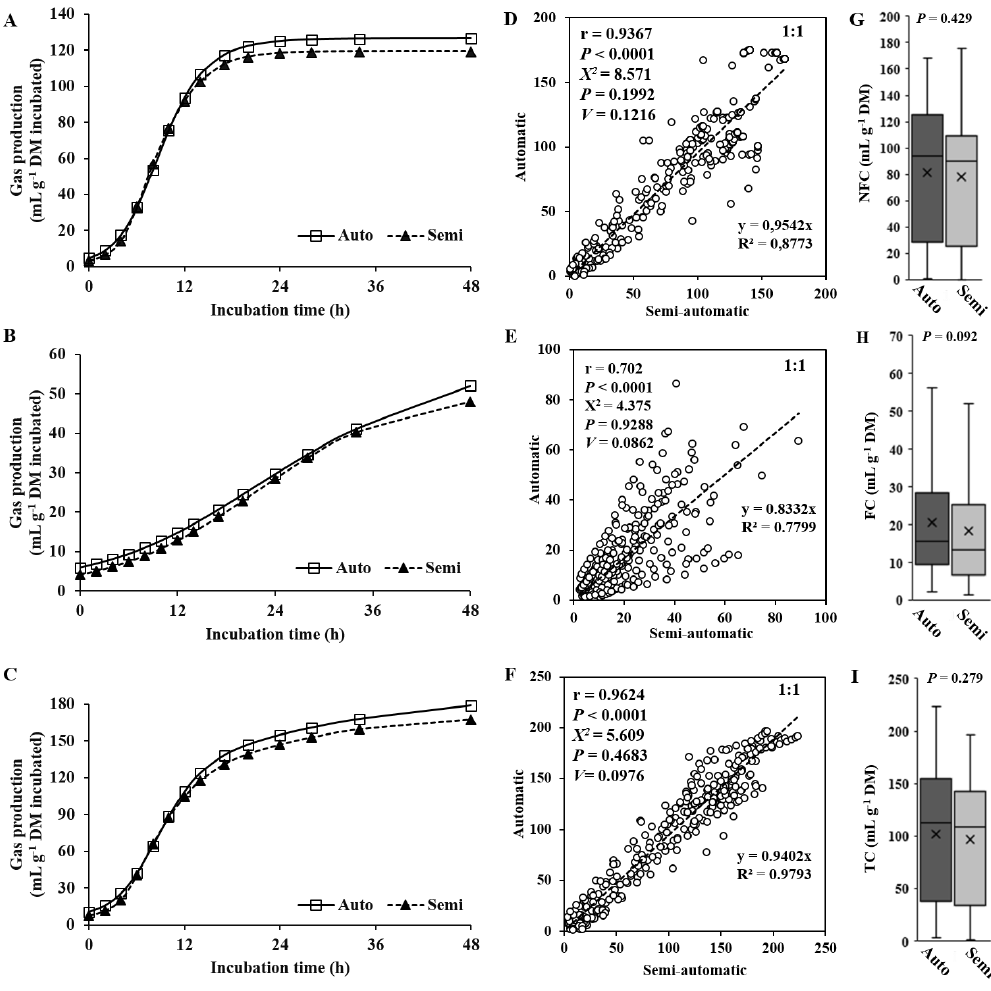
Figure 2. Gas production profiles from fermentation of nonfiber carbohydrates (NFCs) ( A ), fiber carbohydrates (FCs) ( B ), and total carbohydrates (TCs) ( C ) after 48 h of incubation. Dispersion diagrams to assess the correlation between the automatic and semiautomatic techniques for NFCs ( D ), FCs ( E ) and TCs ( F ). Average gas production of gas from the fermentation of NFCs ( G ), FCs ( H ) and TCs ( I ) using the automatic and semiautomatic techniques; r = correlation between the two techniques; p = significance at a 5% probability.